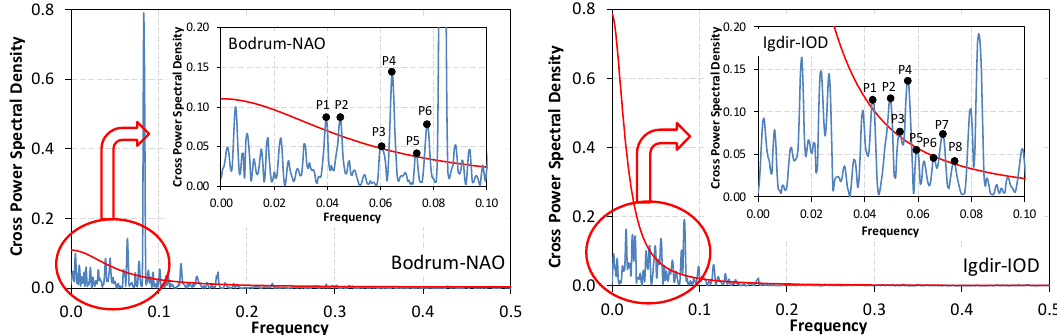
Figure 11. Cross-spectral analysis results of Bodrum-NAO and Igdir-IOD with red noise. The red lines in Figure 11 represent the red noise. A red noise line is drawn to determine the noise that may reach the CPSD values even after the median filter. Red noise is